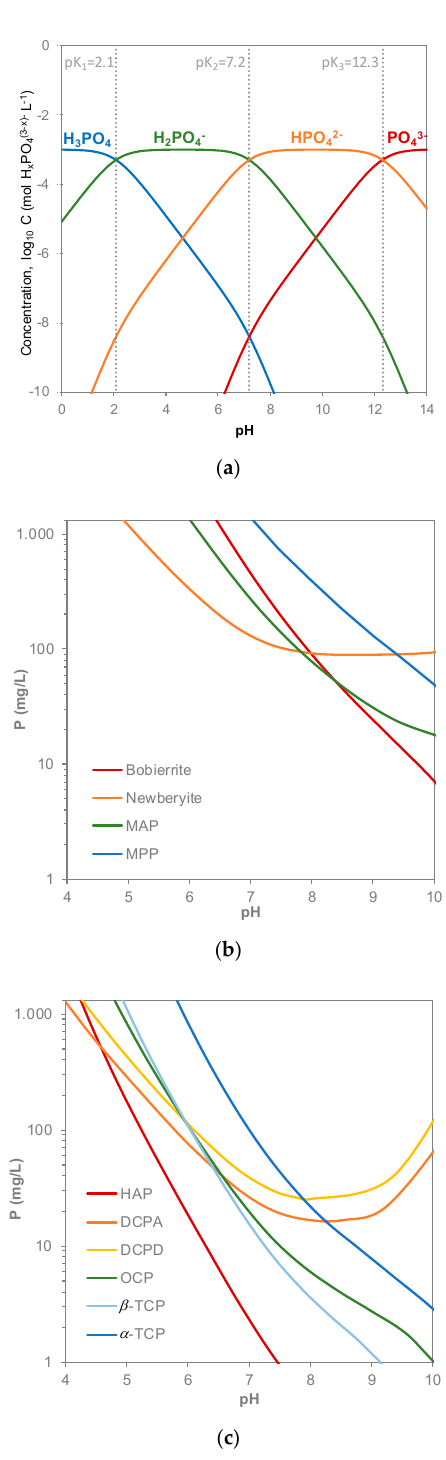
Figure 2. ( a ) Top: Logarithmic concentration diagram for phosphoric acid (1 mM, 25 °C); Soluble Figure2. ( a ) Top: Logarithmicconcentrationdiagramforphosphoricacid(1mM,25 ◦ C);Solubleorthophosphate orthophosphate concentration in water as a function of pH at the equilibrium, according to the concentrationinwaterasafunctionofpHattheequilibrium,accordingtothesolubilityisothermsof: ( b ) Middle: the magnesium phosphate (MgP) phases in the Mg(OH) 2 -X-H 3 PO 4 -H 2 O system at 25 ◦ C. The component X is only considered for MAP as NH 3 , and for MPP as K(OH), and equimolarly to Mg(OH) 2 in both cases. Values for the X / Mg molar ratio higher than 1 will favour precipitation of the solid phase; ( c ) Bottom: the calcium phosphate (CaP) phases in the Ca(OH) 2 -H 3 PO 4 -H 2 O system at 25 ◦ C. At pH values above ~4.5, HAP is the most stable phase. At lower pH values, DCPA is more stable than HAP. Calculations made using Visual MINTEQ